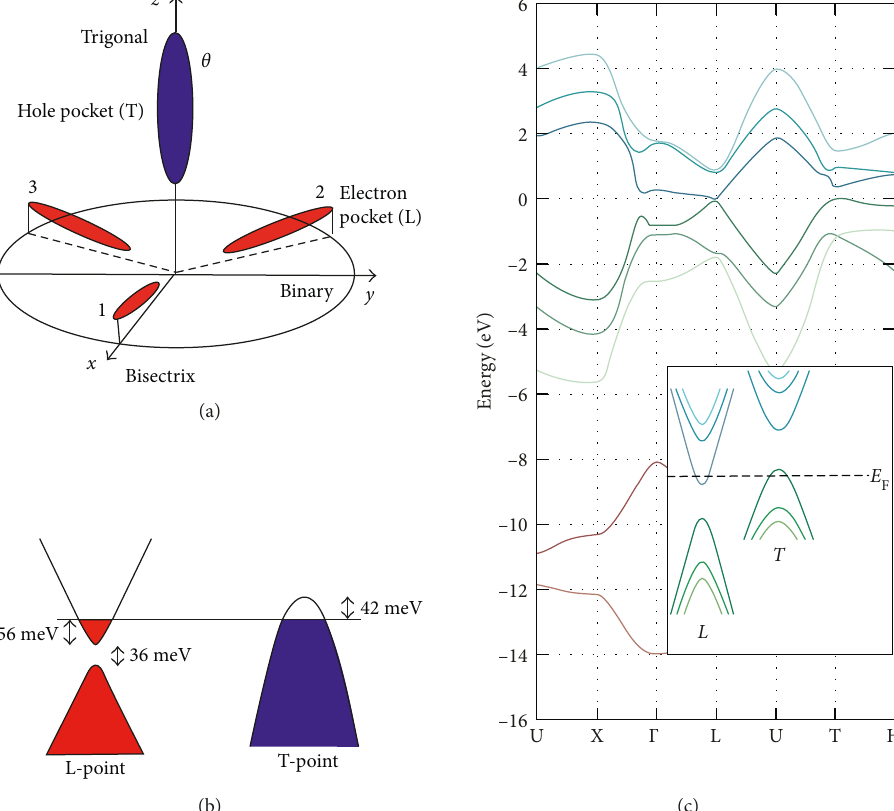
Figure 1: (a) Brillouin zone of bismuth (Bi) in the momentum space: one hole pocket at the T-point and three electron pockets at the T-point. (b) Electronic band structure of Bi near the Fermi level [29, 30]. At room temperature, the direct bandgap at the L-point has an energy of 36meV, the electron Fermi energy at the L-point is 56meV, and the hole Fermi energy at the T-point is 42meV. (c) Full band diagram of Bi calculated by the third-neighbor tight-bonding model accounting for the spin-orbit coupling. Reprinted from [31] © 2015 Fuseya et al., originally published in Journal of the Physical Society of Japan , vol. 84, p. 012001, 2015, doi: 10.7566/JPSJ.84.012001, under CC by 4.0